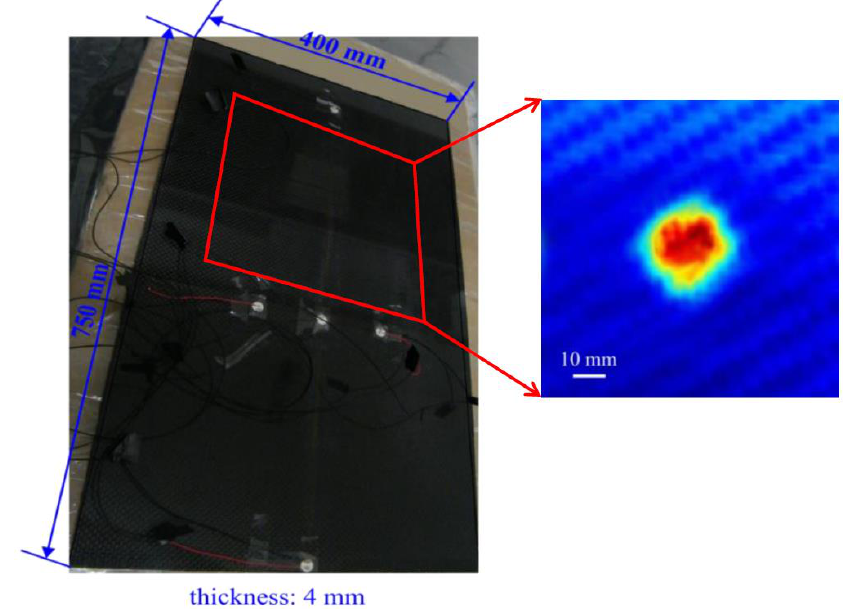
Figure 4. An instrumented composite specimen with a seeded delamination of 19 mm diameter. ( Left ) The instrumented composite panel with a seeded delamination. ( Right ) A zoomed-in ultrasonic phased image of a delamination region.